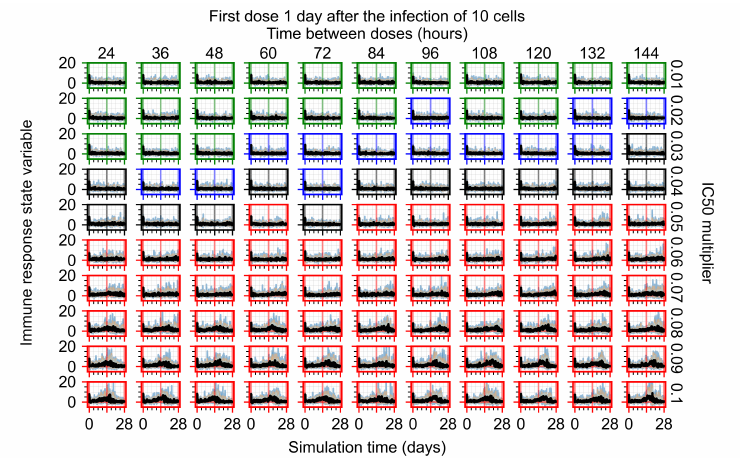
Figure A99. Immune response state variable number. Positive values correspond to an inflammatory state, and negative to an anti-inflammatory state.